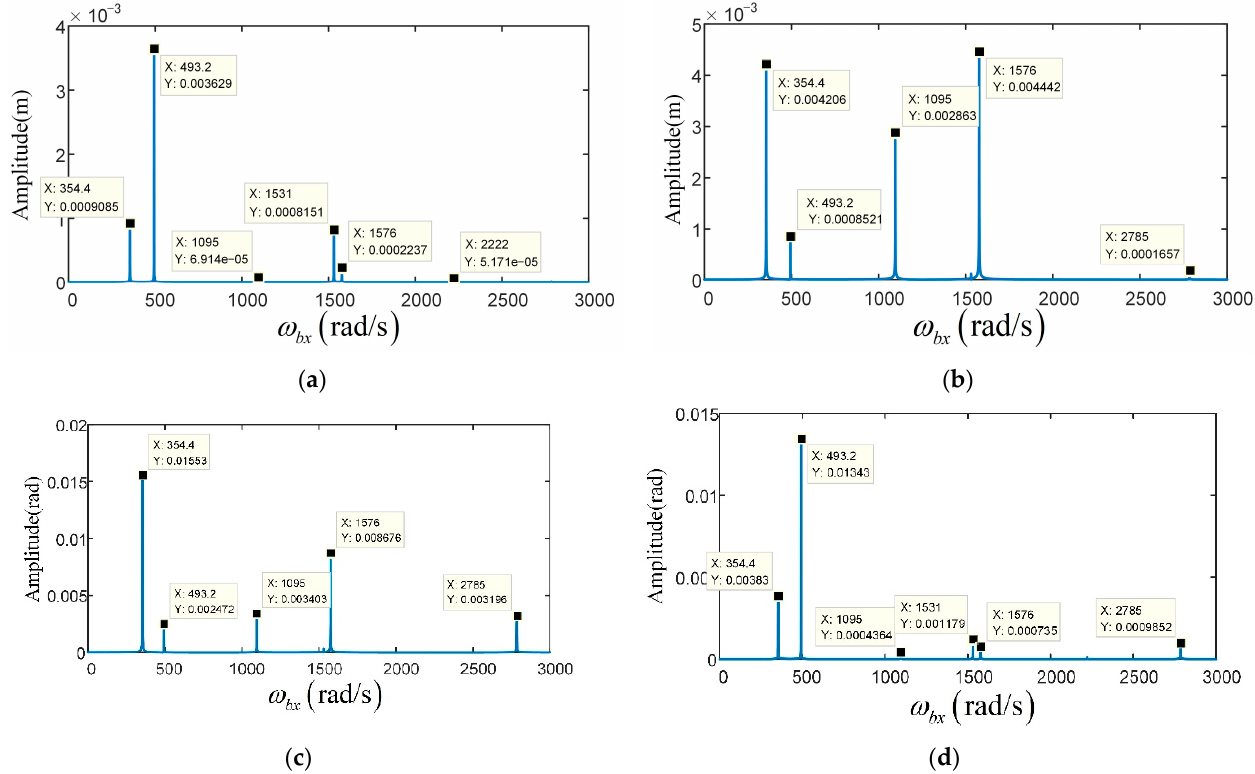
Figure 11. Responses of the dual-rotor system at disk 1 due to gravity with pitching base motion: